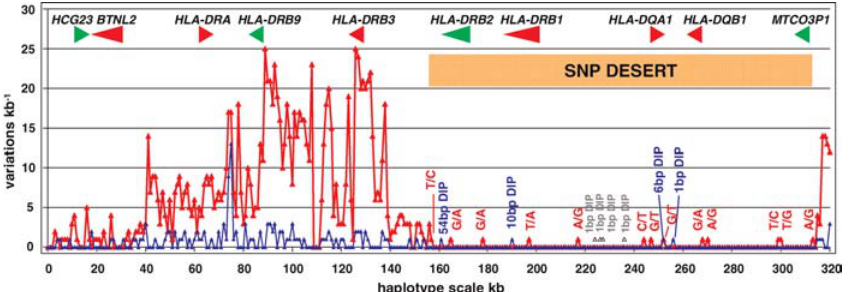
Figure 2. Positional Distributions of Variations between COX and QBL in the HLA-DR Region MHC sequences were divided into 10-kb bins, and variations were calculated in each bin. Results are expressed as variations per 1 kb. Red and blue plots relate to SNP and DIP variations respectively. Within a stretch of approximately 160 kb between HLA-DRB3 and HLA-DQB3, only 14 SNPs and six small DIPs, comprising 1 bp, 6 bp, 10 bp (five copies of a dinucleotide repeat), and 54 bp (two copies of 27 mer), were contained. None of the variations located to coding sequence or the defined promoter regions of the HLA class II genes [86]. Four 1-bp DIPs, labelled in grey, were identified between DRB1 and DQA1 where LR-PCR products were used to close a small gap resulting from clone deficit. These DIPs were located in polyA/T tracts in which the probability of Taq slippage in PCR products is much higher than in in-vivo amplified plasmid DNA such that their authenticity was questionable and they were excluded from analyses (Figure S2 shows one alignment of sequence traces with differing polyT tracts). DOI: 10.1371/journal.pgen.0020009.g002 PLoS Genetics |